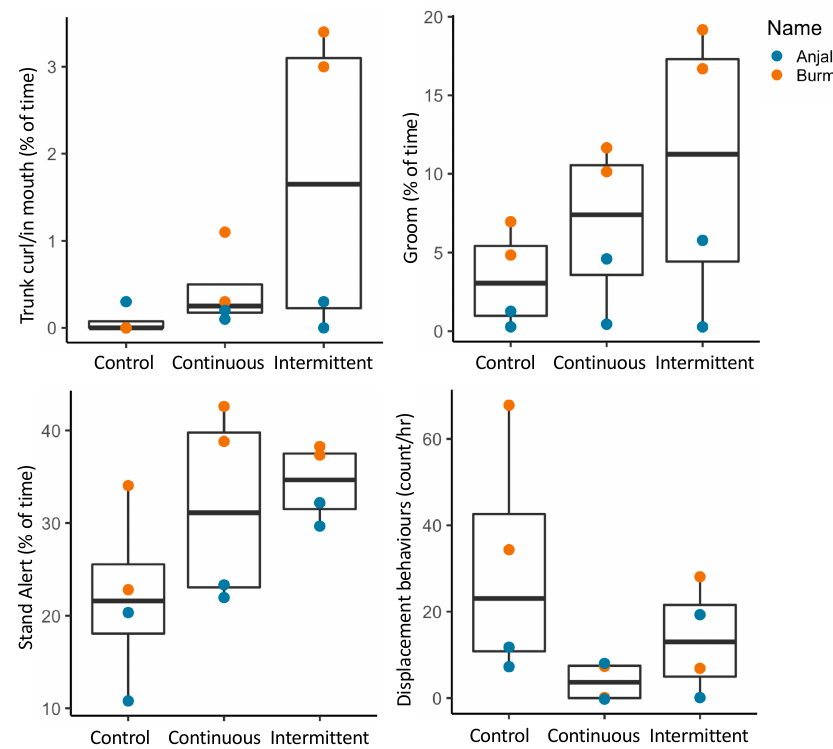
Figure 4. Boxplots of elephant behavior in control, continuous and intermittent noise conditions with symbols identifying individuals.